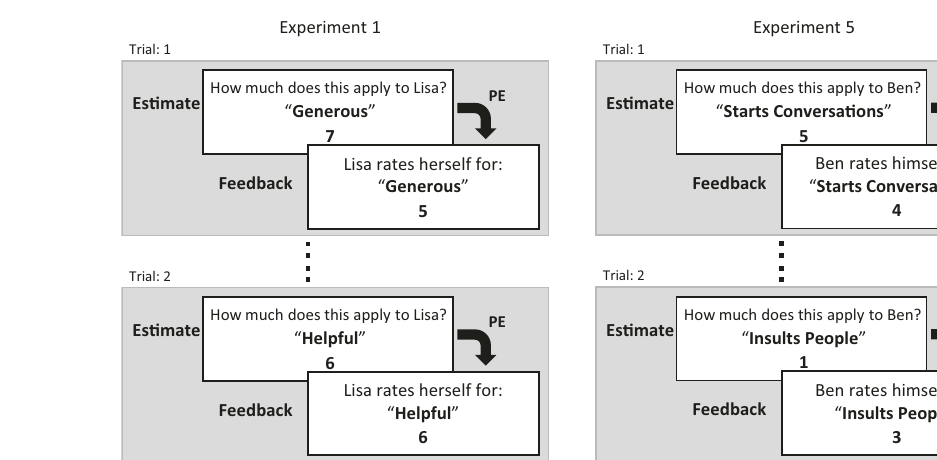
pro fi le)hadgivenforspeci fi ctraits(onaLikertscalefrom1doesnotapplyatallto8 does apply very much). After each estimate, participants received direct feedback in the form of the actual self-rating of that person. This process continued for all traits (in random order). The tasks shown here are translated to English, original German trait words and sentences can be found in Supplementary Tables 1 – 3.